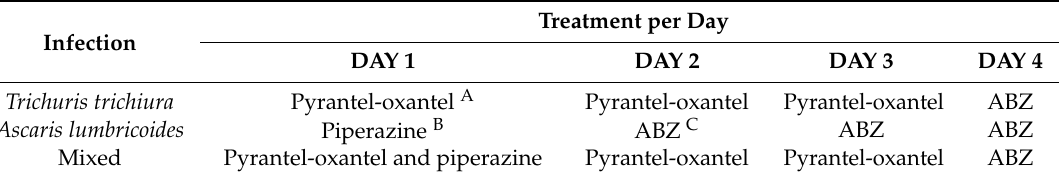
Table 1. Treatment scheme used to recover adult worms from infected children, according to type of infection. ABZ: